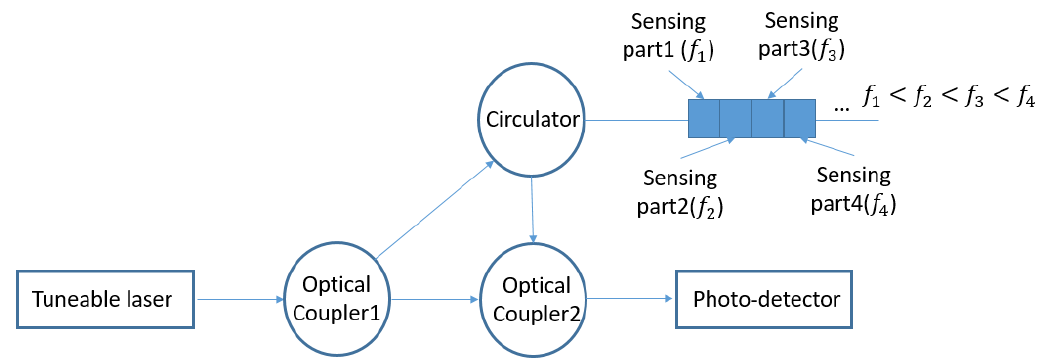
Figure 2. Schematic of an Optical Time Domain Reflectometry Rayleigh Backscattering Sensors System.